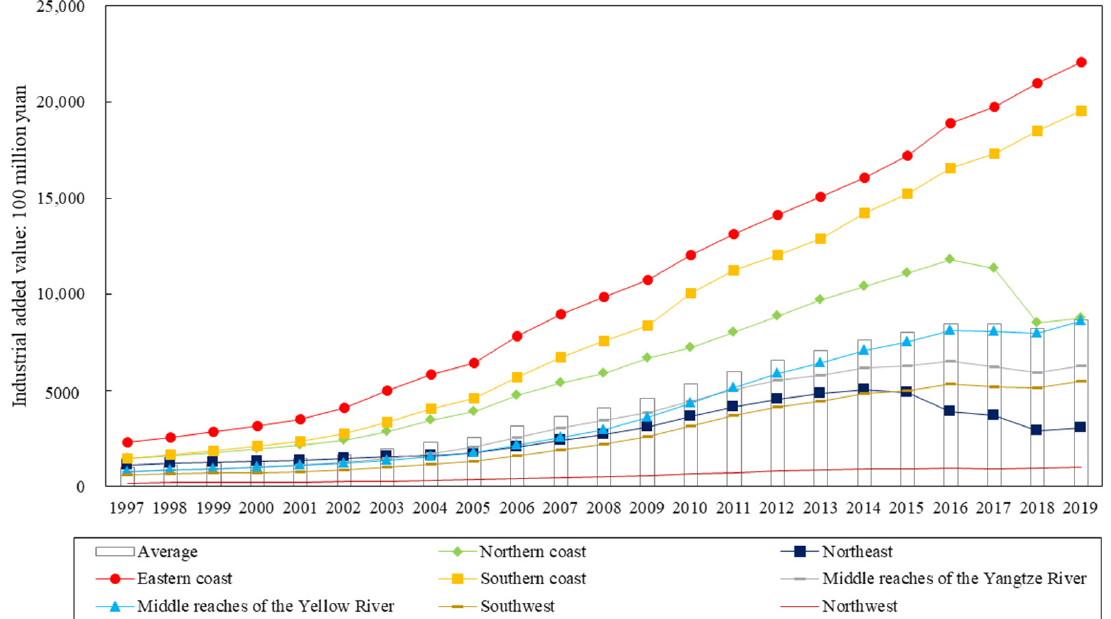
Figure 2. Changes in average industrial added value in China’s eight major economic zones.